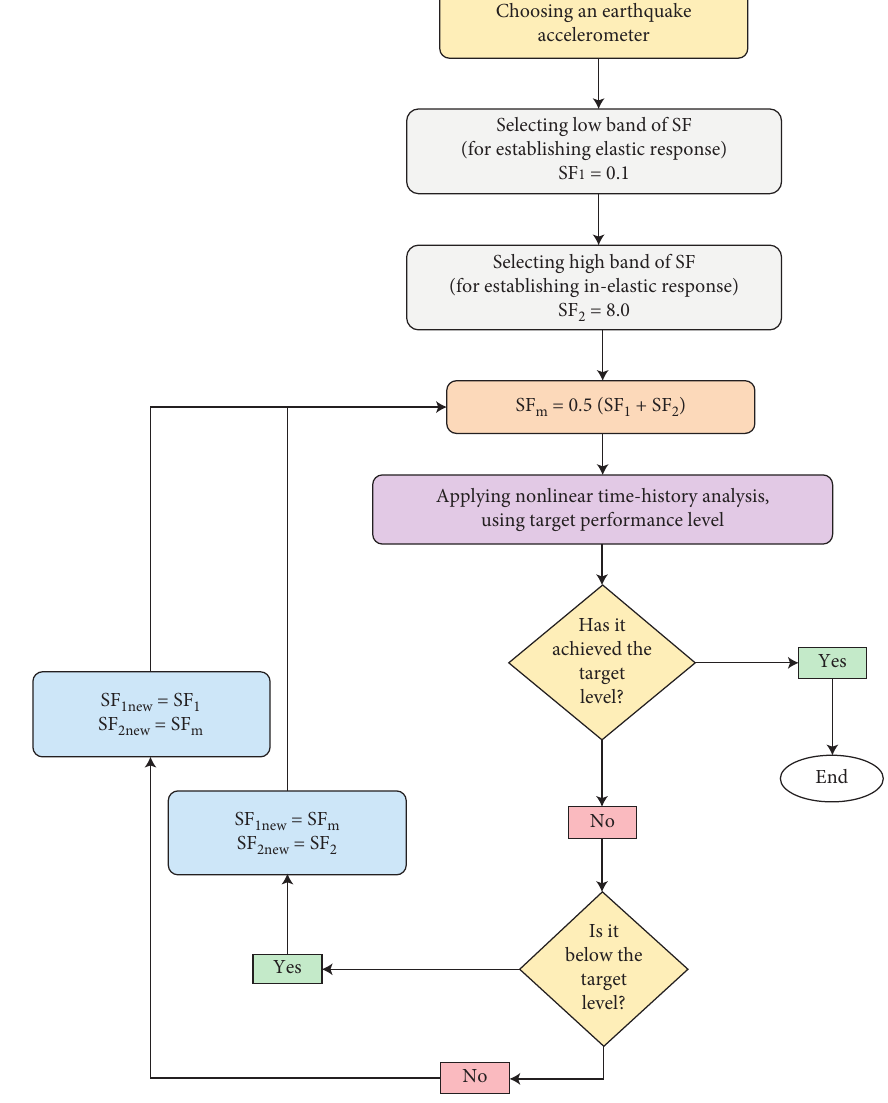
Figure 4: Flowchart of the change in scale factor. Table 2: Section sizes of the 6St-EBFs by Fakhroddini et al.